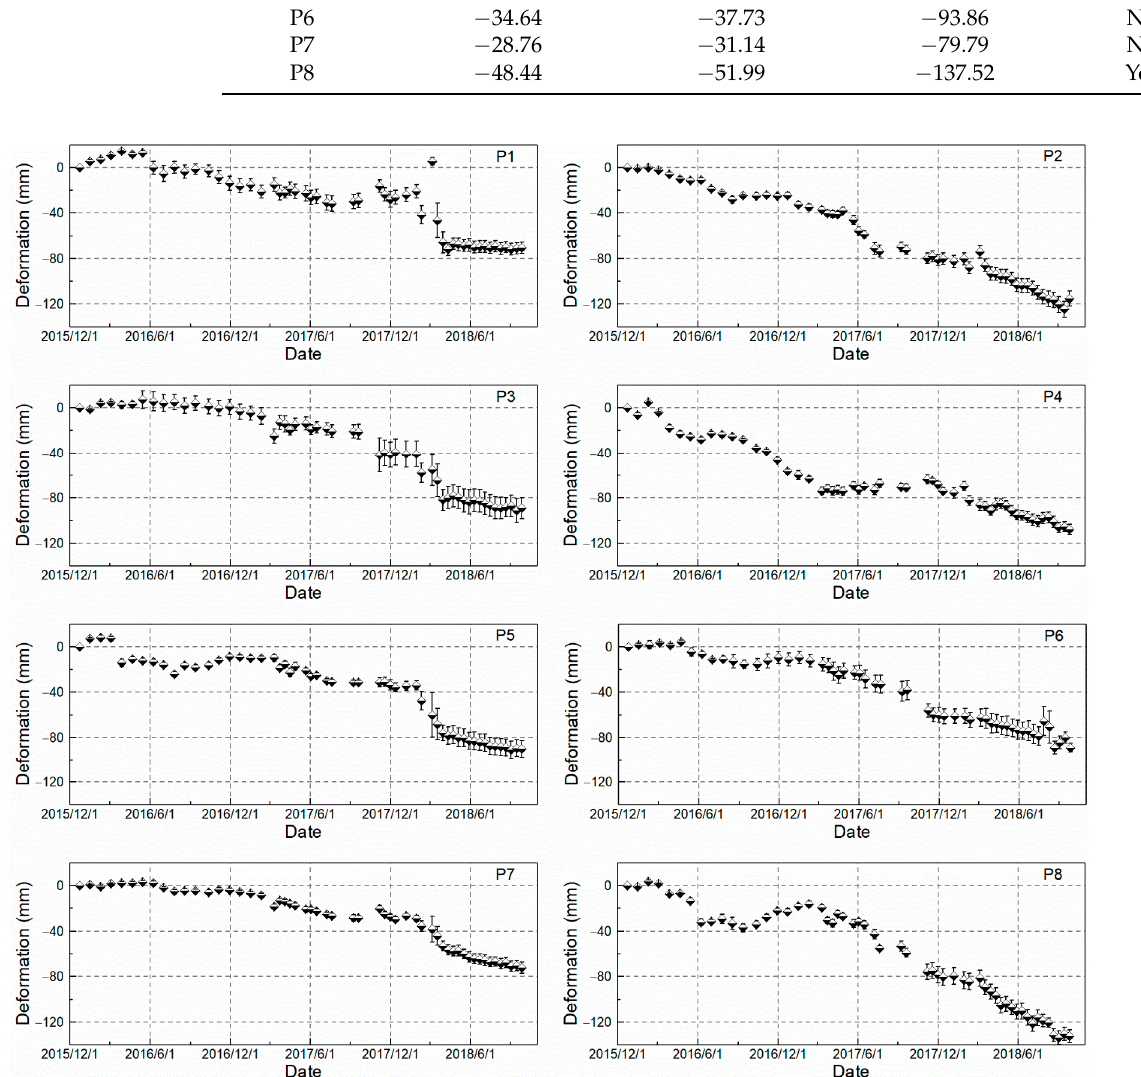
Figure 4. The time series of the cumulative deformation in regions P1–P8. The vertical error bars indicate the standard deviation of the cumulative amount of deformation in each selected region.